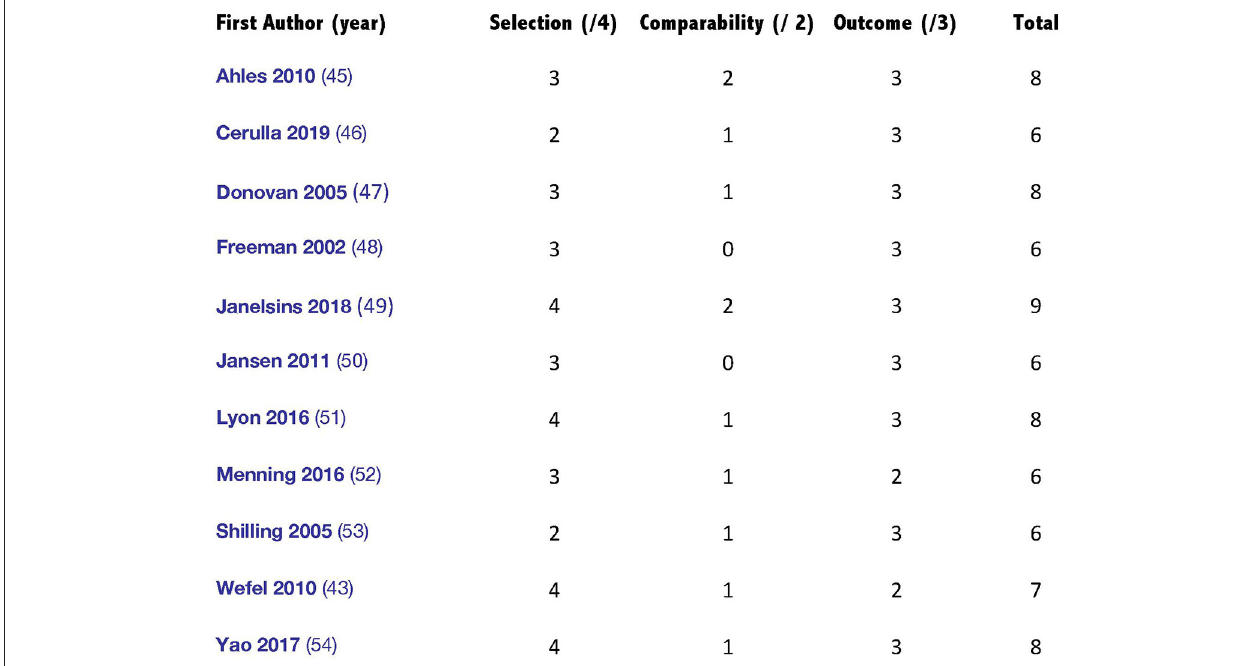
FIGURE 2 | Summary of critical appraisal of included studies using the Newcastle–Ottawa Scale (NOS).